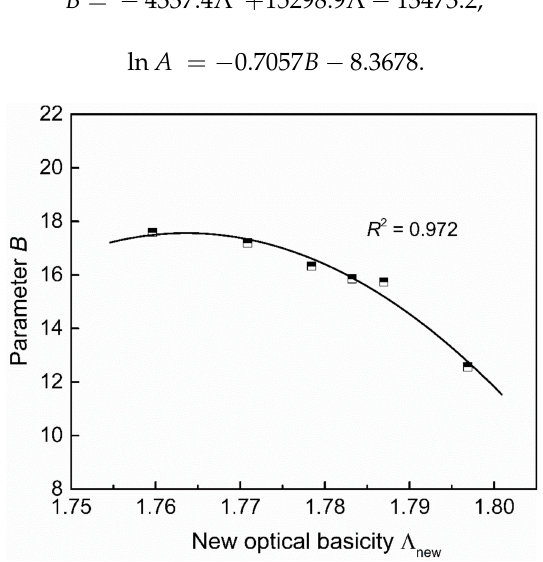
Figure 10. The relationship between the new optical basicity ( Λ new ) and parameter B .